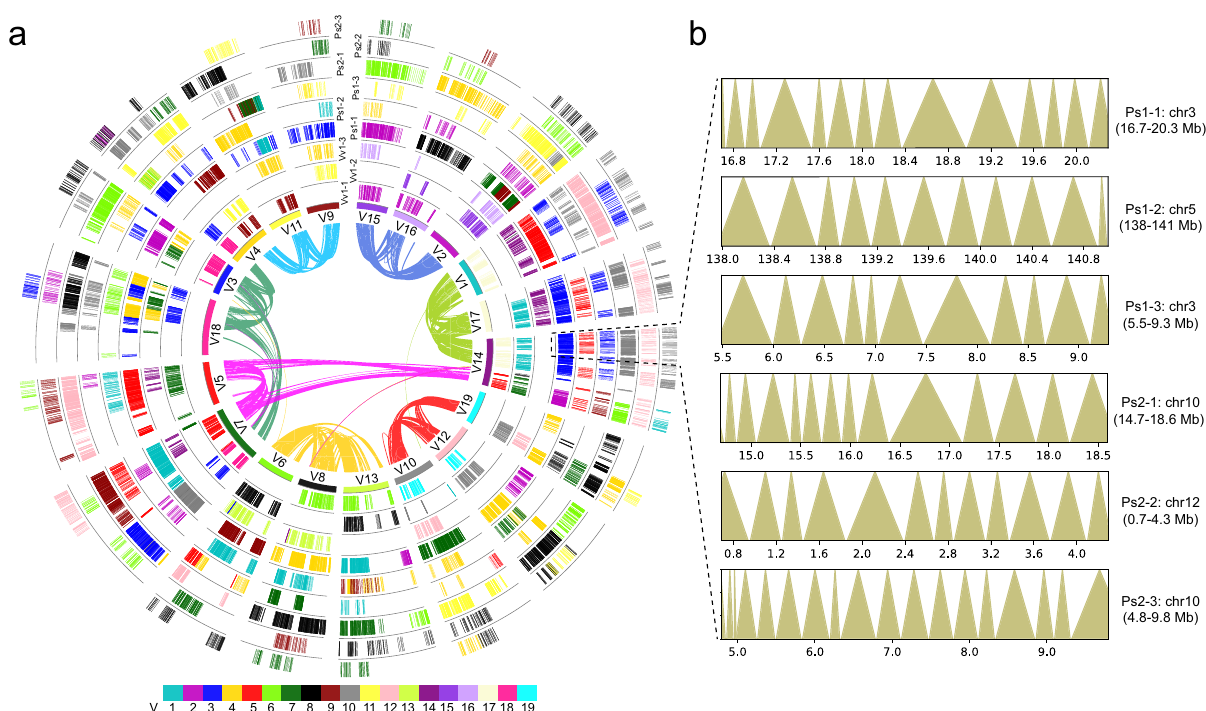
Fig. 2 Global alignment of ginseng genomic regions to the grape genome and chromatin topology of the paleo-polyploidization-derived homologous regions in ginseng. a Collinearity was determined by genes (referred to as ancestral core-eudicot gene) that were collinear between ginseng and grape genomes. The 19 extant grape chromosomes (V1 – V19) in the innermost circle are color-coded to different colors according to the color bar at the bottom. Curved lines within the inner circle connect homoeologous genes duplicated by the γ triplication. Colors of these curved lines correspond to the seven ancestral core-eudicot chromosomes (Eu1 – Eu7) 19 . A genomic region in grape has three and six homologous regions compared to itself and ginseng genomes, respectively. The three grape circles (Vv1-1, Vv1-2, and Vv1-3) are the result of the core-eudicot γ triplication. The middle three (Ps1-1, Ps1-2, and Ps1-3) and outside three (Ps2-1, Ps2-2, and Ps2-3) circles are also the result of the core-eudicot shared γ triplication plus the Pg- β duplication, respectively. The short lines within each genomic region of the nine circles represented the predicted ancestral core-eudicot genes. Grape genes have initials “ Vv ” or “ V ” and ginseng genes “ Ps ” . Colors of these core-eudicot genes represent their physical locations on the 19 grape and 12 ginseng chromosomes, respectively. The six homologous genomic regions included in black dashed line were selected to compare chromatin topology. b From top to bottom are the topological association domain-like (TADs-like) structures of the six selected homologous genomic regions. Both the top three (extant Panax chromosome 3, 3, and 5) and bottom three (extant Panax chromosome 10, 10, and 12) regions resulted from the γ triplication, while the top and bottom three homologous genomic regions, in turn, resulted from the Pg- β duplication (giving rise to Ps1 and Ps2). The numbers on x -axis indicate physical positions on extant ginseng chromosomal segments. Triangle size represents the length of each TAD on the ginseng chromosome. Source data are provided as a Source Data fi